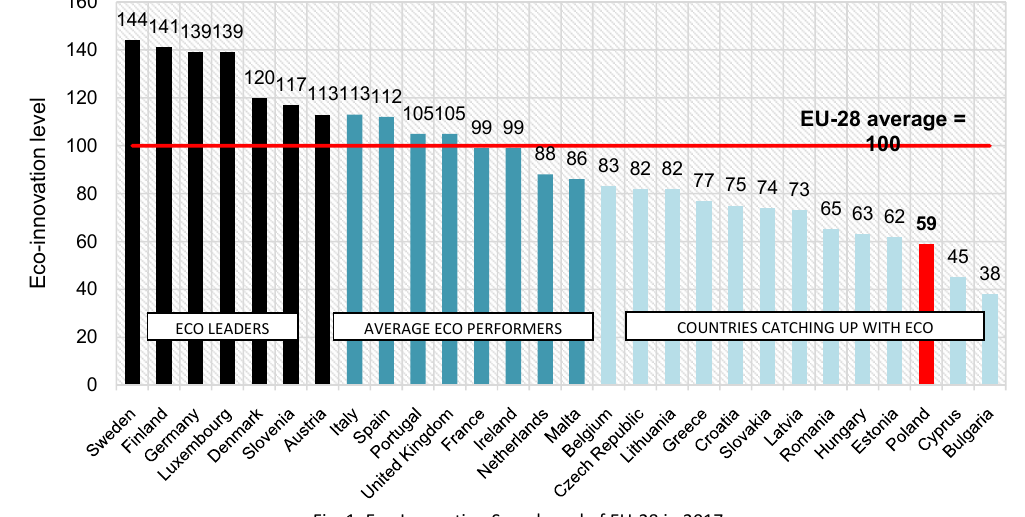
Fig. 1: Eco-Innovation Scoreboard of EU-28 in 2017 Fig. 1: Eco ‐ Innovation Scoreboard of EU ‐ 28 in 2017